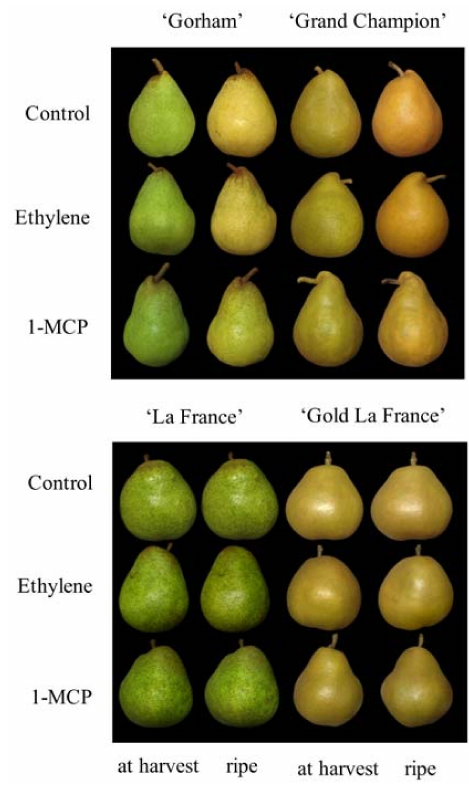
Figure 3. Fruit appearance of ‘Gorham’, ‘Grand Champion’, ‘La France’, and ‘Gold La France’ pears treated with ethylene and 1-MCP during ripening at 20 ◦